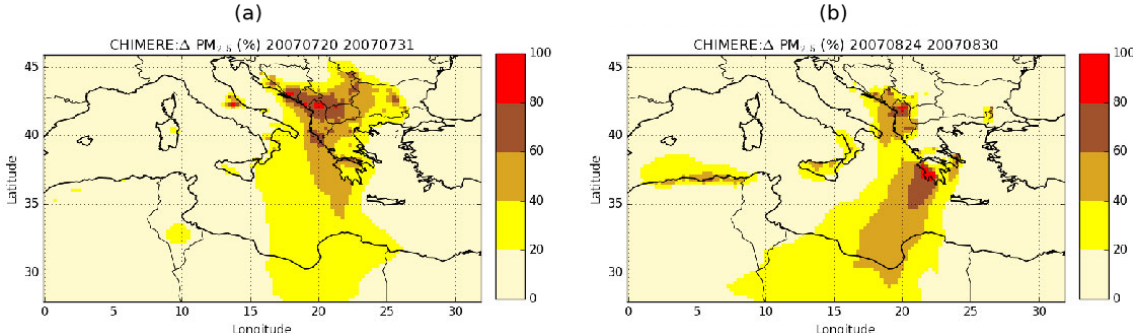
Figure C1. (a) Relative difference of surface PM 2 . 5 concentrations between simulations CHIMERE-ref and CHIMERE-Nofires during the first fire event. (b) Relative difference of surface PM 2 . 5 concentrations between simulations CHIMERE-ref and CHIMERE-Nofires during the second fire event.